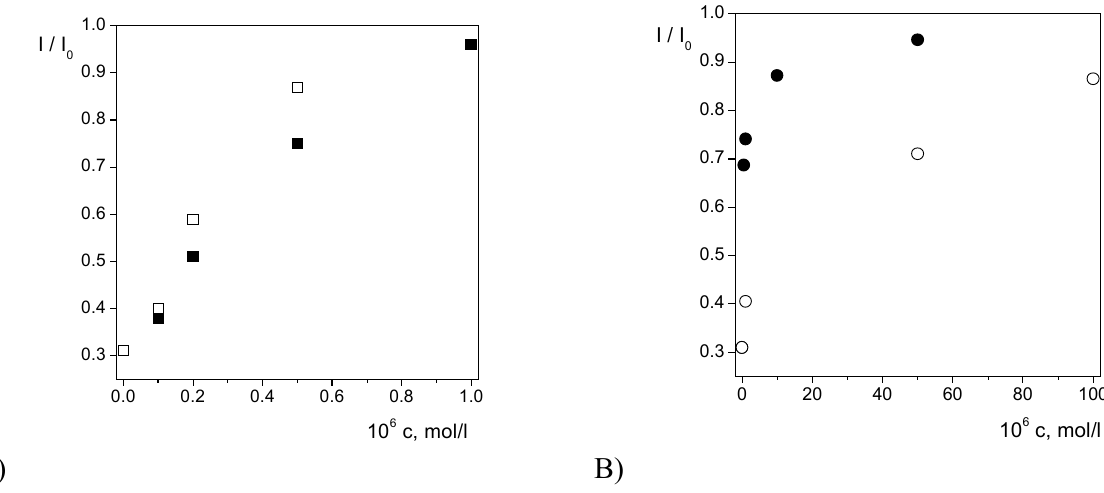
Figure 4. Dependence of the relative [Co(phen) DNA/CPE incubated for 10 min at room temperature in a cleavage mixture of 5 × 10 -7 mol/l [Cu(phen) ] 2+ , 1 × 10 -3 mol/l ascorbic acid and 1 × 10 -2 mol/l H 2 rutin ( (cid:3) ), (B) epigallocatechin gallate ( (cid:1) ) or catechin ( (cid:4) ).Other conditions as in Figure